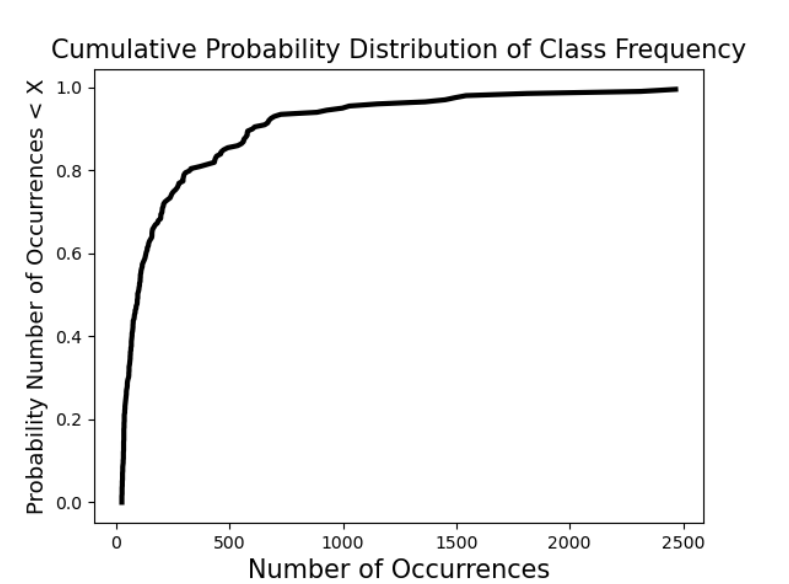
Figure 4. A cumulative class distribution plot showing the distribution of frequencies at which different classes appear in ARTSv2. The x -axis indicates a class frequency, and the y -axis value indicates the probability that a class occurs at most the number of times indicated on the x -axis. The sharp rise on the left side of the graph shows there are many classes that appear with low frequency, posing a unique challenge for geo-localization algorithms, which must adapt to classes with few training